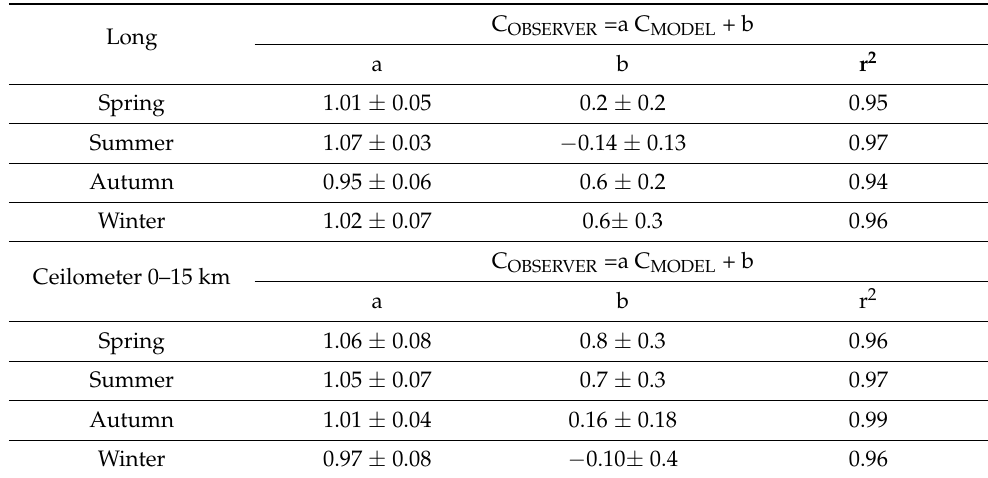
Relationships between automatic and visual methods: linear regressions (total cloud